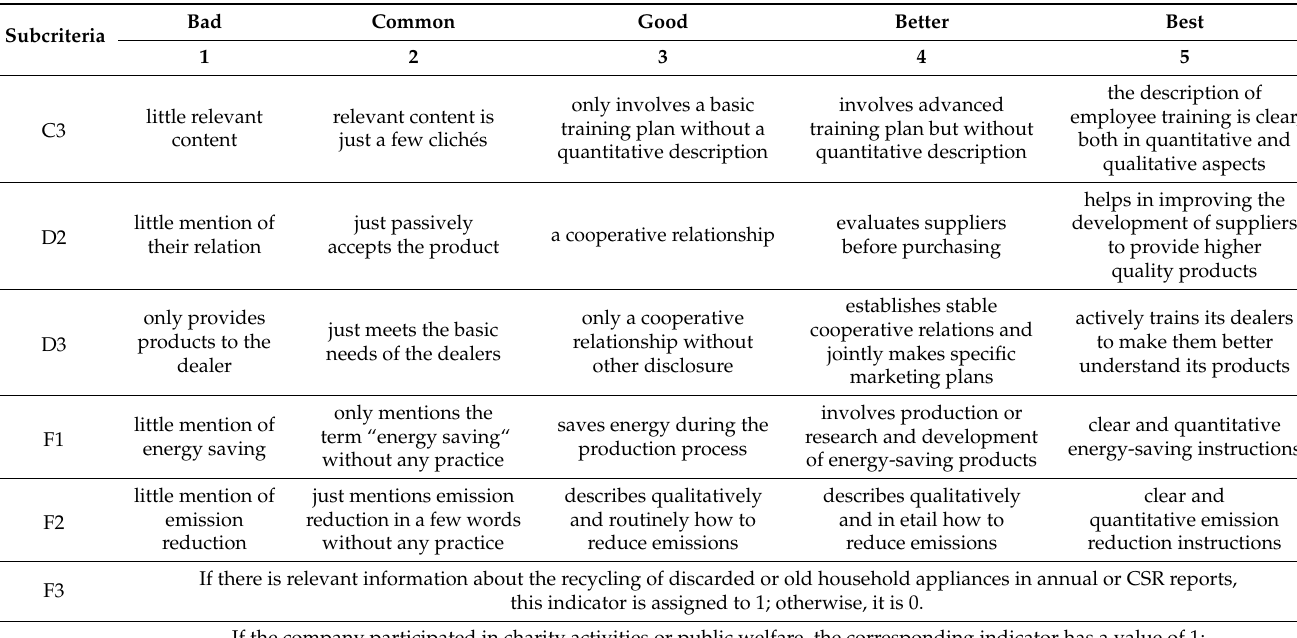
Table 2. Description of scales of qualitative subcriteria.